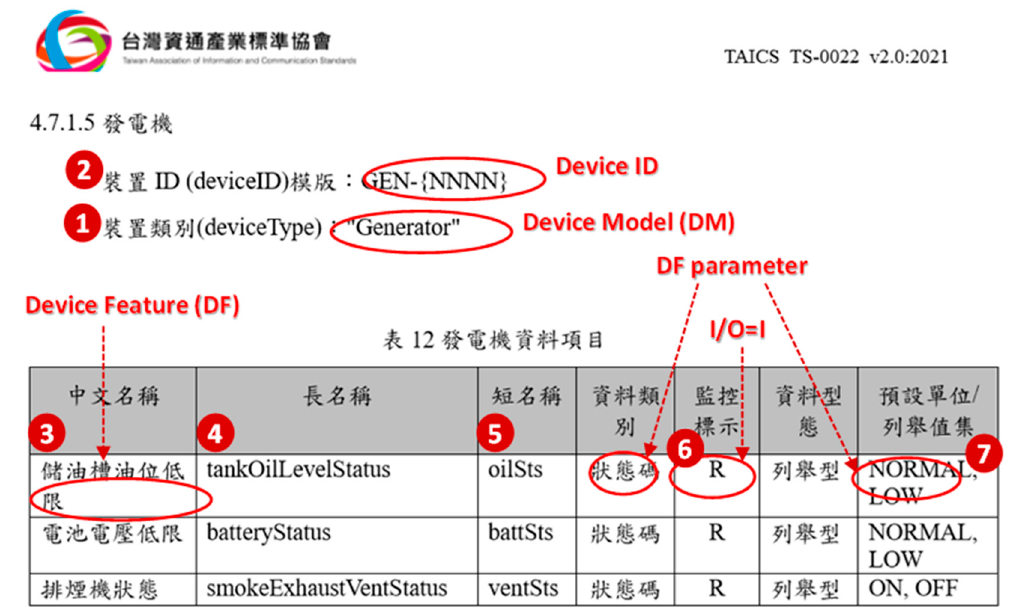
Figure 1. The TAICS specification for “Generator”.